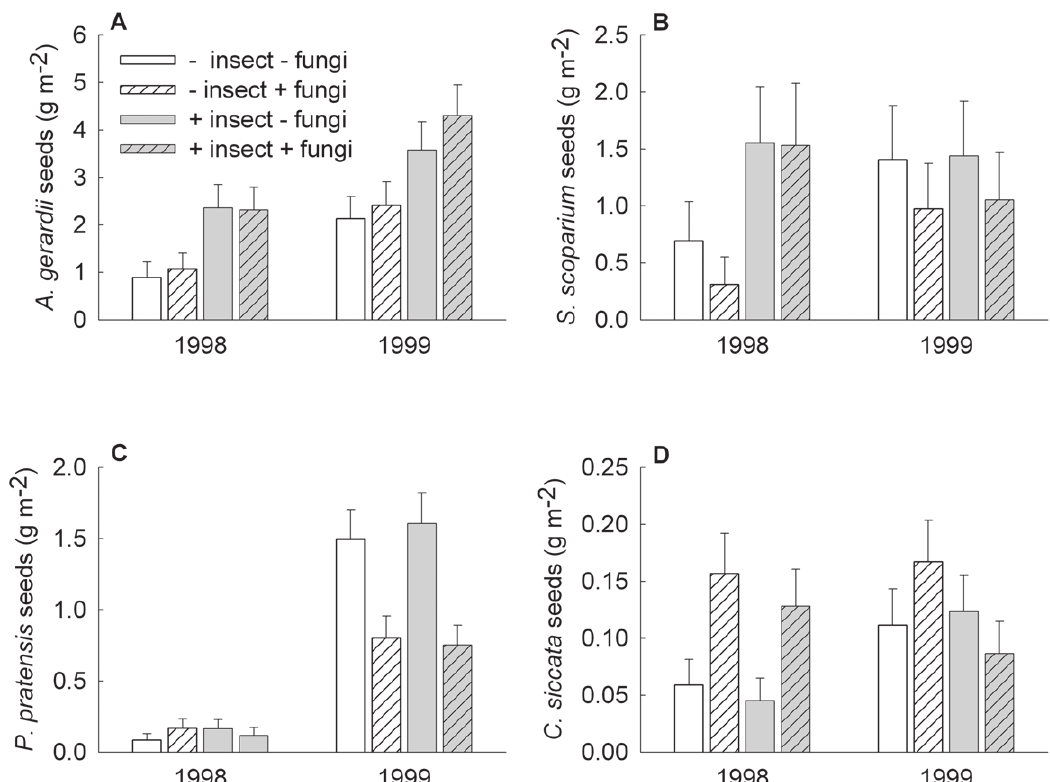
Figure 1. The effects of insecticide, fungicide, and year on total seed mass per square meter. Effects are shown for (A) Andropogon gerardii , (B) Schizachyrium scoparium , (C) Poa pratensis , and (D) Carex siccata (error bars are + 1 standard error).